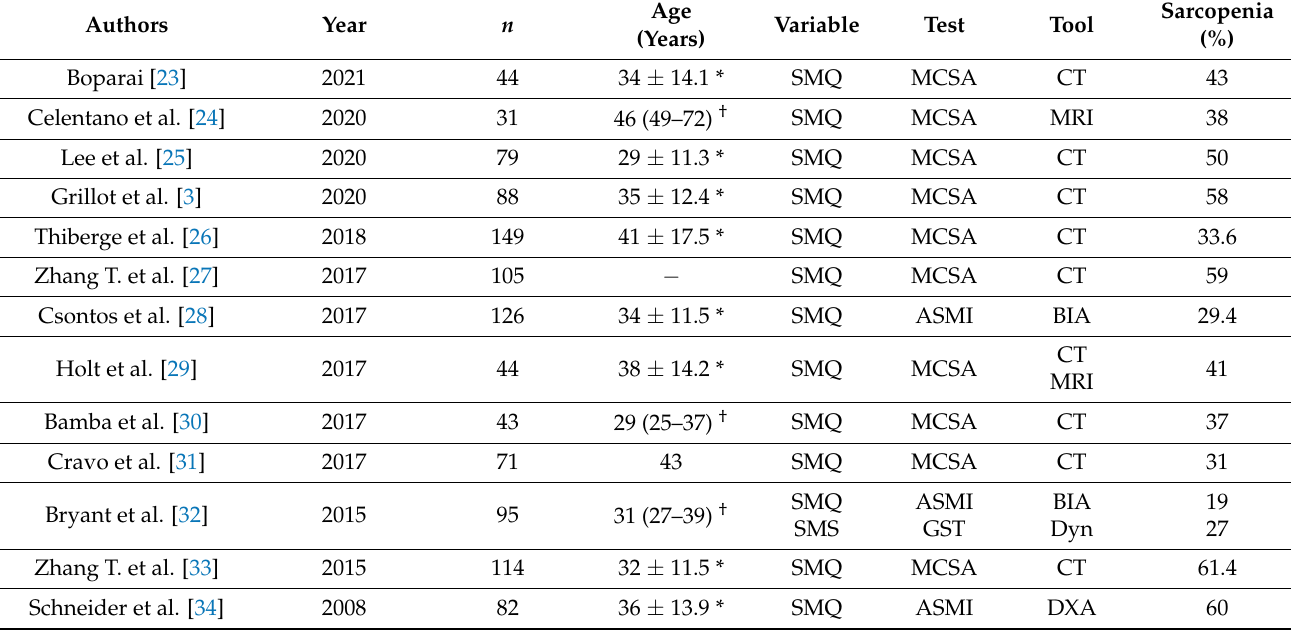
Table 2. Prevalence of Sarcopenia in Crohn’s Disease